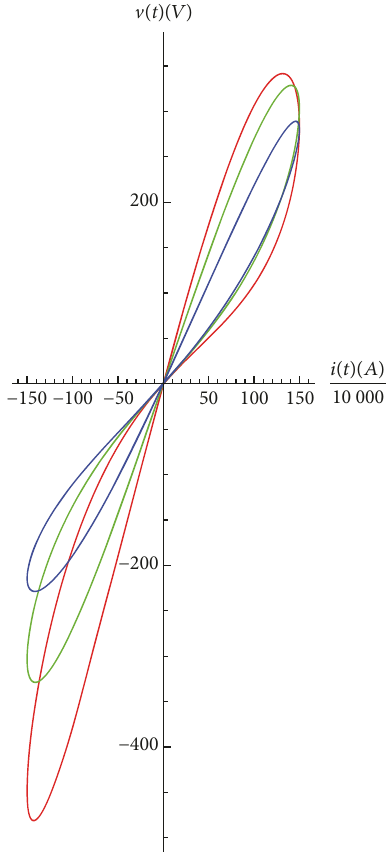
Figure 19: V (𝑡) - 𝑖(𝑡) of the fractional order memristor at asymptotic